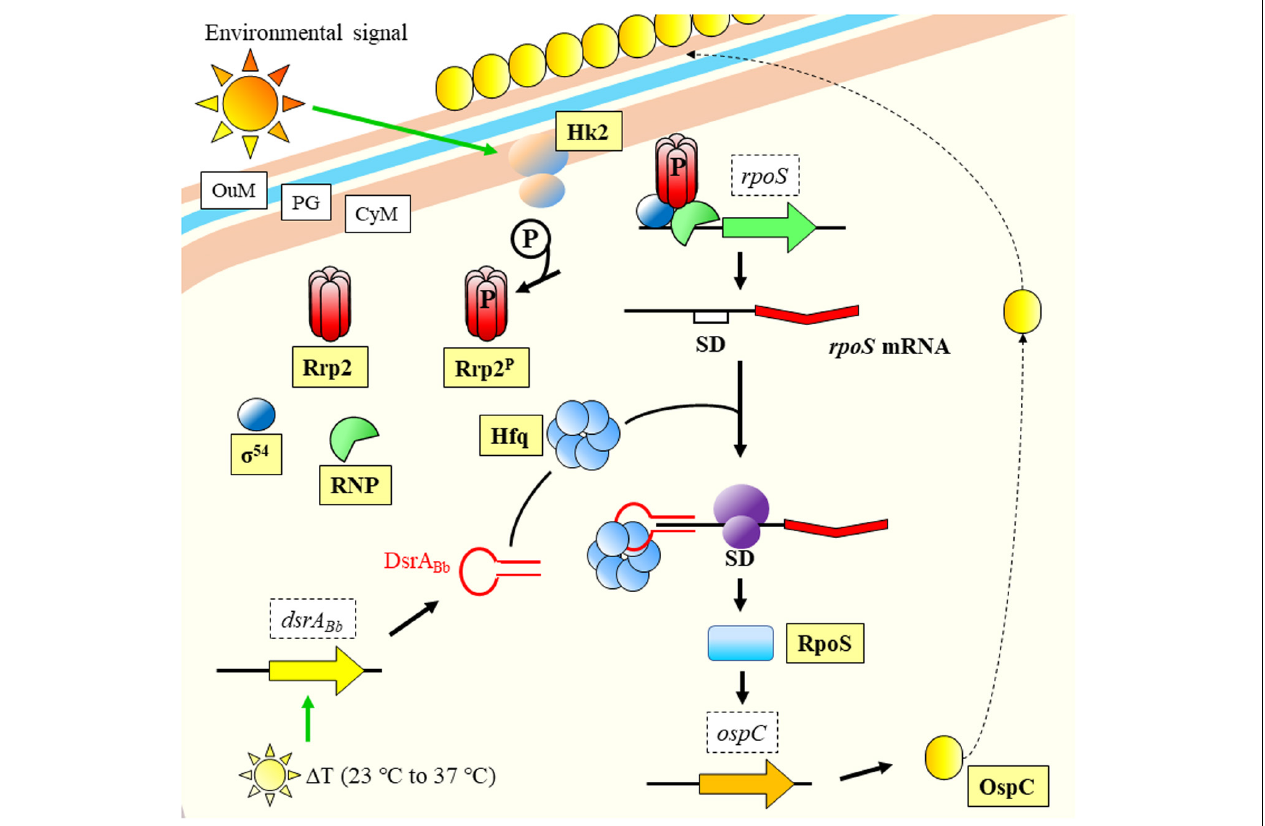
FIGURE 2 | Temperature response model of Borrelia burgdorferi . An environmental signal activates Hk2 membrane protein that phosphorylates and activates Rrp2. Together with RNP and σ 54 , they facilitate transcription of rpoS . The mRNA is stabilized by the joint action of DsrA Bb (expressed upon temperature increase to host conditions) and Hfq, and the messenger is translated into protein. RpoS regulates the transcription of ospC , which product is displayed on the OuM. CyM, Cytoplasmic membrane; OuM, Outer membrane; PG, peptidoglycan; RNP, RNA Polymerase; SD, Shine-Dalgarno. Black thick arrows indicate flow of a biological process, e.g., protein translation. Green thick arrows indicate activation. References: Burtnick et al., 2007; Lybecker and Samuels, 2007; Lybecker et al., 2010; Radolf et al., 2012; Steere et al.,